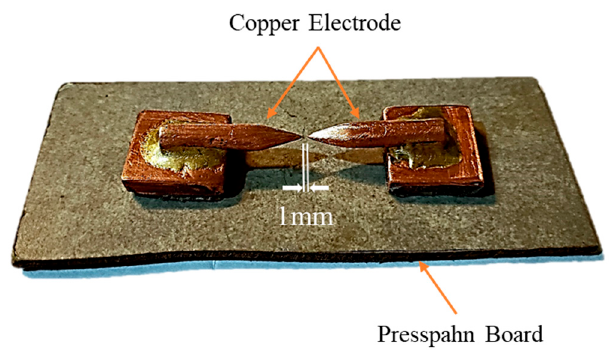
Figure 3. The copper electrode used to generate partial discharge (PD source).